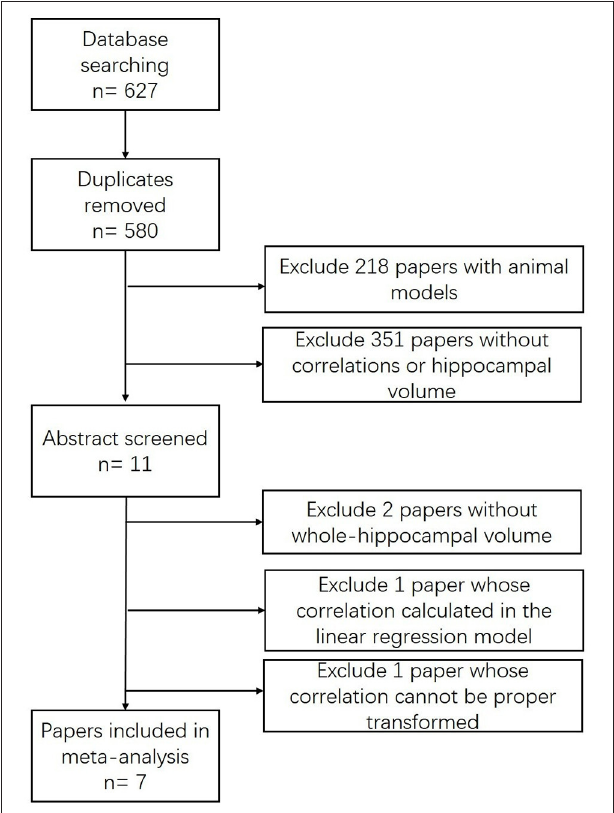
FIGURE 1 | Flow chart of study